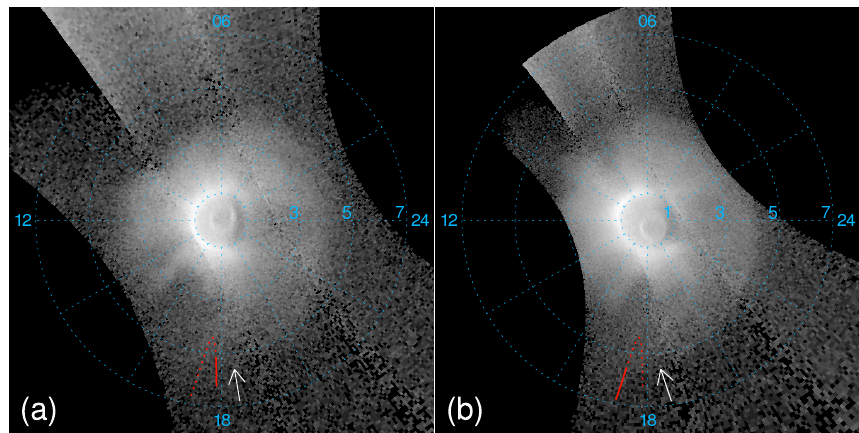
Fig. 2. Plasmaspheric images captured by IMAGE EUV and mapped to the magnetic equator on 12 June 2002 at (a) 00:18UT and (b) 02:00UT. Cluster (C1) orbital elements between 00:13UT and 02:14UT mapped to the equator along dipolar magnetic field lines are drawn by solid or dotted lines in red. The solid lines indicate Cluster orbital elements which correspond to plume crossings (00:13–00:35UT and 01:57–02:14UT) during when each image was taken, while the dotted lines indicate the rest of Cluster orbital elements. The view is from the northern pole. Leftside corresponds to noon MLT (magnetic local time). Selected L-values (1–7) and MLTs (06:00–24:00MLT) are noted in the figure. Density is enhanced in the duskside as indicated by